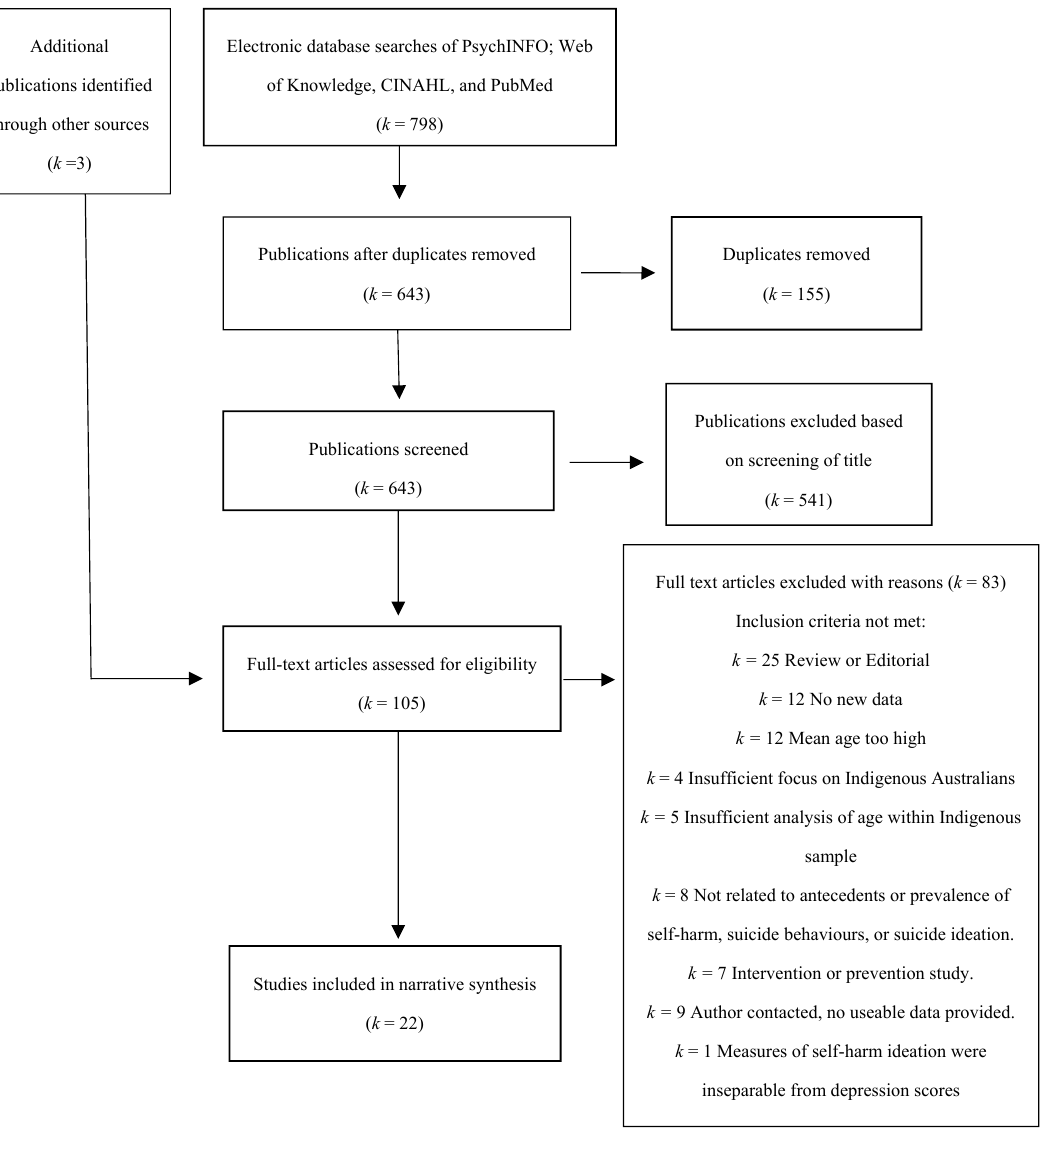
Figure 1. Study Figure 1. Study selection.